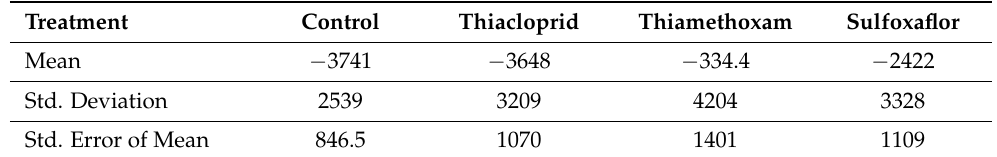
Figure 5. Distance travelled by bees in the lower concentration trials. ( A ) Total distance travelled pre-training. One-way ANOVA with Tukey correction for multiple comparisons, thiamethoxam p = 0.027 *, thiacloprid p = 0.66, sulfoxaflor p = 0.72. Thiacloprid vs sulfoxaflor p = 0.99, thiamethoxam vs. sulfoxaflor p = 0.24, thiamethoxam vs thiacloprid p = 0.28. ( B ) Total distance travelled post- training. One-way ANOVAs with Tukey correction for multiple comparisons, control vs. thiacloprid p = 0.86, control vs. thiamethoxam p = 0.99, control vs. sulfoxaflor p = 0.99, thiacloprid vs. thi- amethoxam p = 0.67, thiacloprid vs. sulfoxaflor p = 0.75 and thiamethoxam vs. sulfoxaflor p = 0.99. ( C ) Total distance travelled pre- versus post-training. Paired t -tests, control p = 0.0022 **, thiacloprid p = 0.0092 **, sulfoxaflor p = 0.06, thiamethoxam p = 0.817. ( D ) Difference in distance travelled (post-training − pre-training value). A negative value is indicative that a bee travelled less distance post-training vs. pre-training. Control n = 9, thiacloprid n = 9, thiamethoxam n = 9, sulfoxaflor n = 9. Table 1. Statistics of differences in distance travelled (mm) pre- vs. post-training in the lower concentration